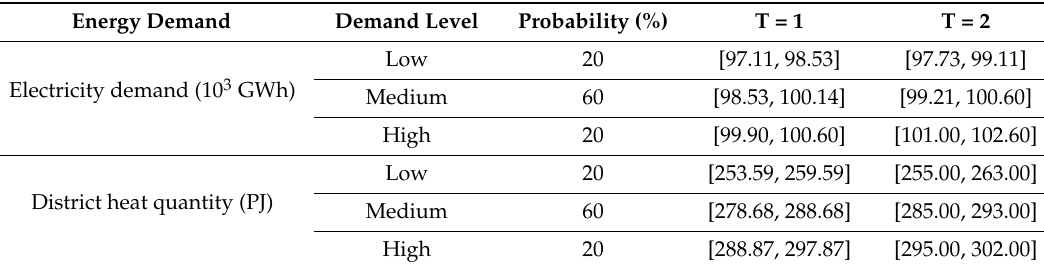
Table 1. Regional electricity and heat demand during the planning